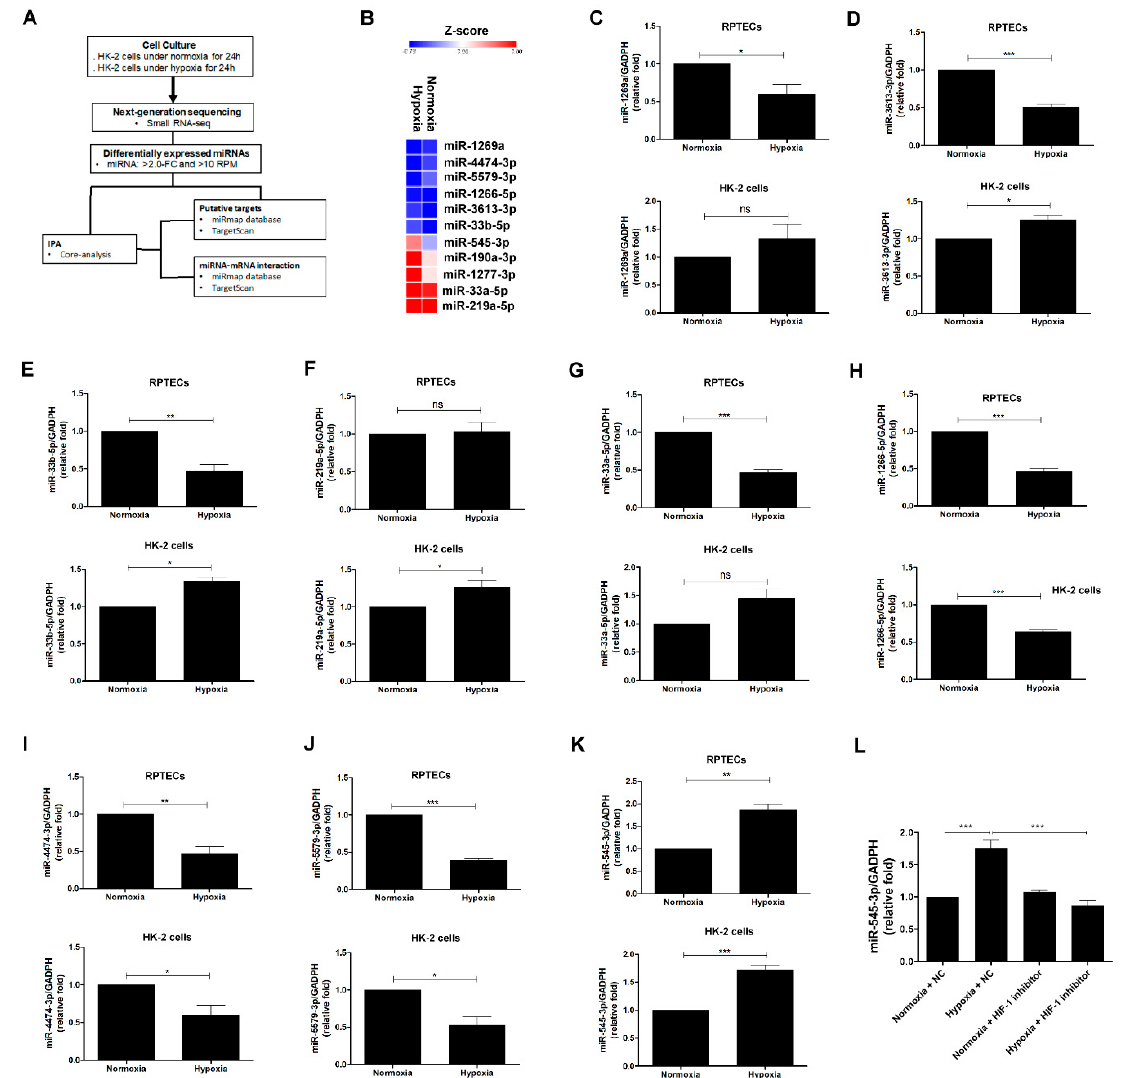
Figure 2. Identification of miR-545-3p participating in hypoxia-induced EMT in PTECs. ( A ) Flowchart of the identification of potential miRNAs associated with hypoxia-induced EMT in HK-2 cells. ( B ) The heat map displayed differential expression from HK-2 cells under normoxia and hypoxia with Z-score values. miR-1269a ( C ), miR-3613-3p ( D ), miR-33b-5p ( E ), miR-219a-5p ( F ), miR-33a-5p ( G ), miR-1266-5p ( H ), miR-4474-3p ( I ), miR-5579-3p ( J ), and miR-545-3p ( K ) levels in human RPTECs and HK-2 cells cultured under normoxia and hypoxia for 48 h were assessed by quantitative real-time PCR. miR-545-3p expression was also examined in HK-2 cells treated with HIF-1 inhibitor (10 uM) under normoxia and hypoxia for 48 h ( L ). The bar graph represents the mean ± SEM of at least three independent experiments. * p < 0.05, ** p < 0.01, *** p < 0.001 by Student’s t -test.